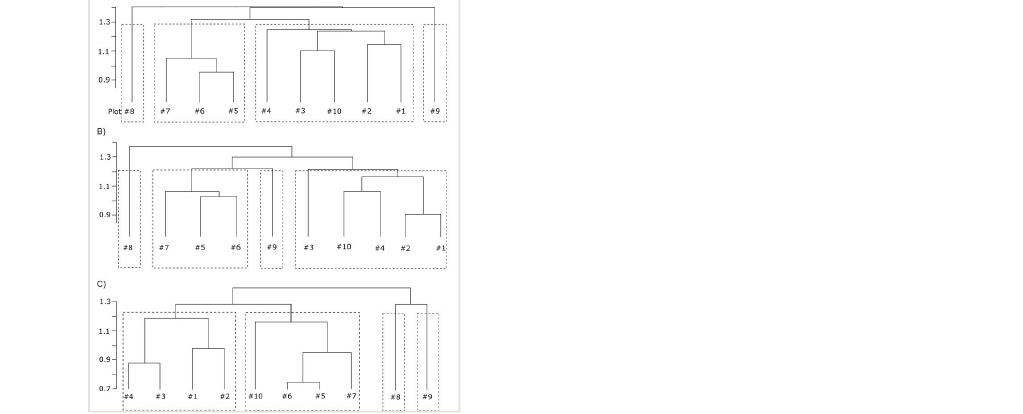
Cluster dendrogram built by average agglomerative clustering (UPGMA) based on chord distance matrix of abundance data of vegetation amongst 10 plots of macromycetes observations in di ff erent forest types in vicinities of Khanty-Mansiysk, West